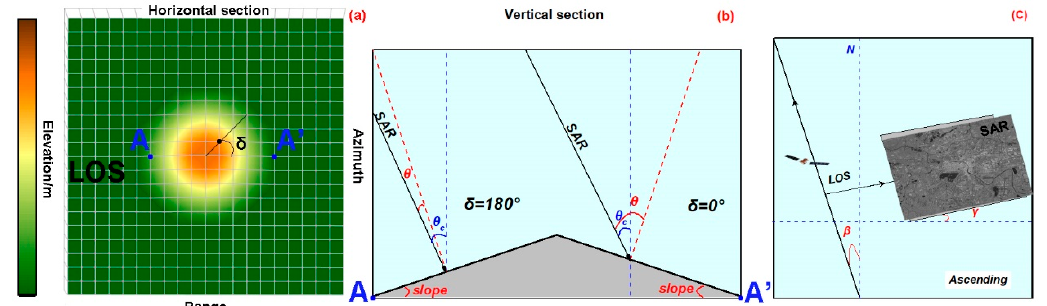
Figure 8. The schematic of the local incidence angle inversion: ( a ) the horizontal section of the ideal area with equal slope mountain and flat, where each cell corresponds to the sampling point of SAR; ( b ) the vertical section of the line AA’ in Figure 8a, illustrating the relations between θ and θ c while δ = 0 ◦ and 180 ◦ ; ( c ) the heading angle β of the satellite at the ascending mode with right side-looking imaging based on the Sentinel-1A configuration.